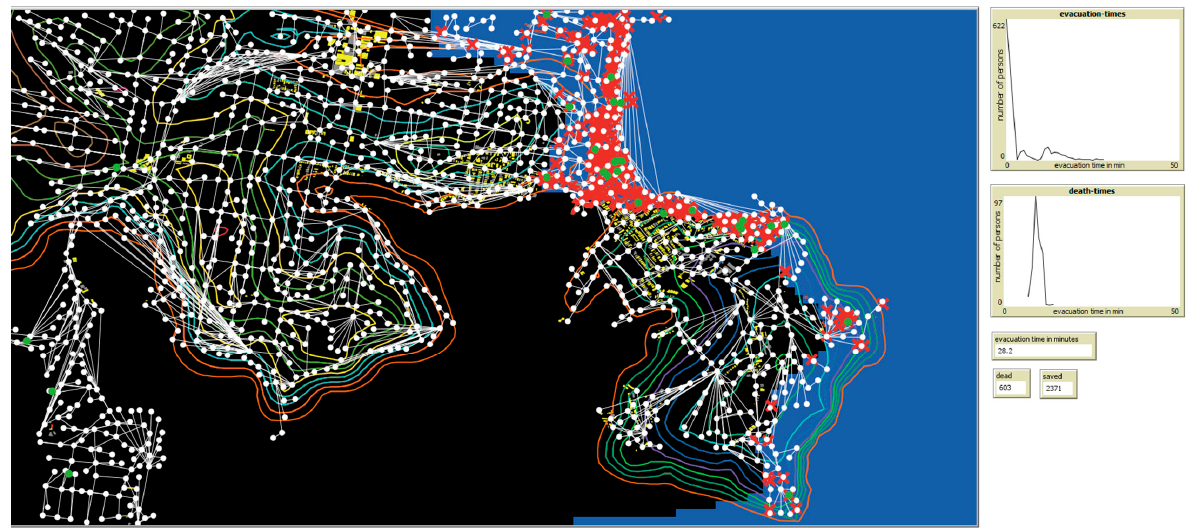
Figure 10. Visualisation of evacuation simulation of the Manly suburb in Sydney, Australia (see Figure 2 for the map of the area). The blue colour represents the tsunami wave propagating approximately from right to left. The white lines are the roads taken from the Open Street Map data. Yellow are the buildings also based on OpenStreetMap data. The white points are the intersections or places with differing elevations. The agents are moving along these lines. The coloured lines are the elevation contours. Red crosses represent inhabitants struck by the tsunami. The charts on the right show the number of inhabitants successfully finding shelter and inhabitants struck by the tsunami, respectively.